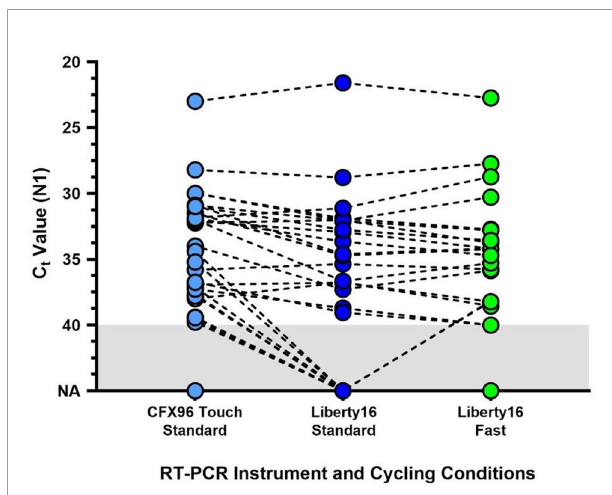
FIGURE 2 | Comparison of the standard SalivaDirect PCR and updated fast cycling protocols on SARS-CoV-2 virus RNA N1 detection. De-identi fi ed clinical saliva samples, previously tested using the standard SalivaDirect protocol on the CFX96 Touch, using the NEB Luna 2x PCR mastermix were also run on the Liberty16 system using the standard RT-qPCR (95°C, 10s; 55°C, 30s) or fast RT-qPCR (95°C, 2s; 55°C, 5s) cycling conditions. The same reverse transcriptase activation conditions (52°C, 10min; 95°C, 2 min) were used for both runs. The resulting SARS-CoV-2 N1 (Ct) values did not differ between either Liberty16 protocol (Wilcoxon p > 0.1). Two out of 21 sample pairs (10%) yielded not detected (ND) values when run using the standard protocol, while 2 pairs yielded Ct values of 40 and 41 respectively. Ten samples, previously positive when tested on the CFX96 Touch were not detected by either Liberty16 protocol. All were previously shown to have Ct values at or below the limit of detection of the Liberty16 device running the SalivaDirect